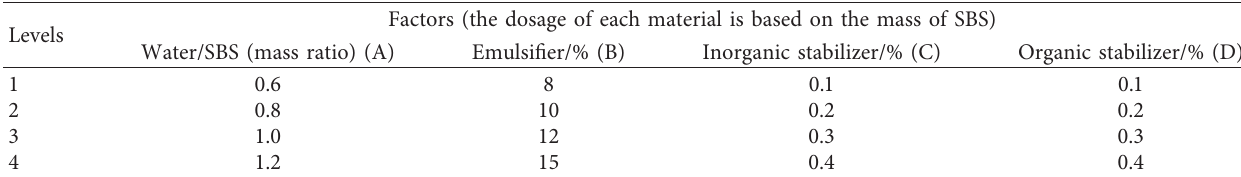
Figure 6: The appearance of SBS solution in the presence of a red laser light passageway. Table 2: Factors and levels of orthogonal experimental design.